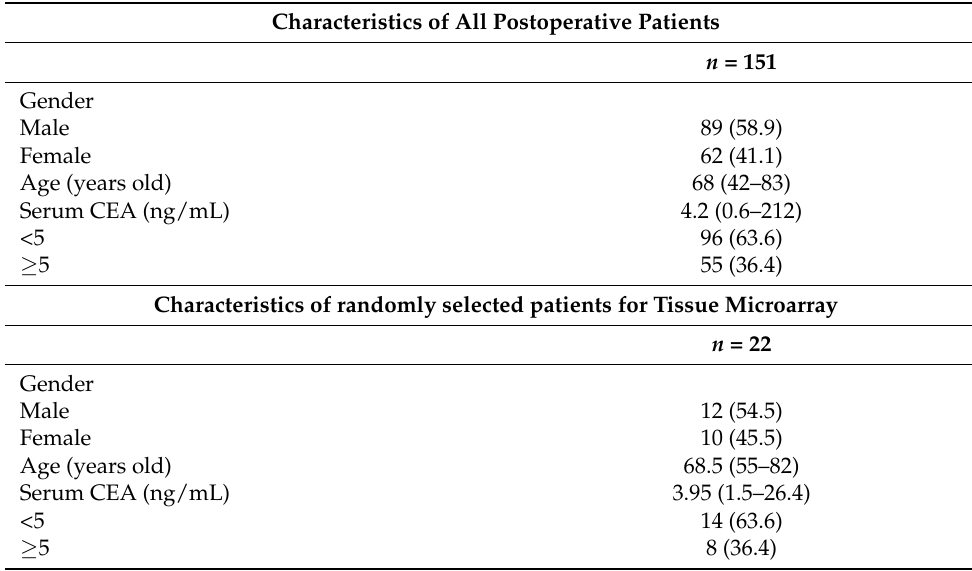
Table 1. Characteristics of pancreatic adenocarcinoma